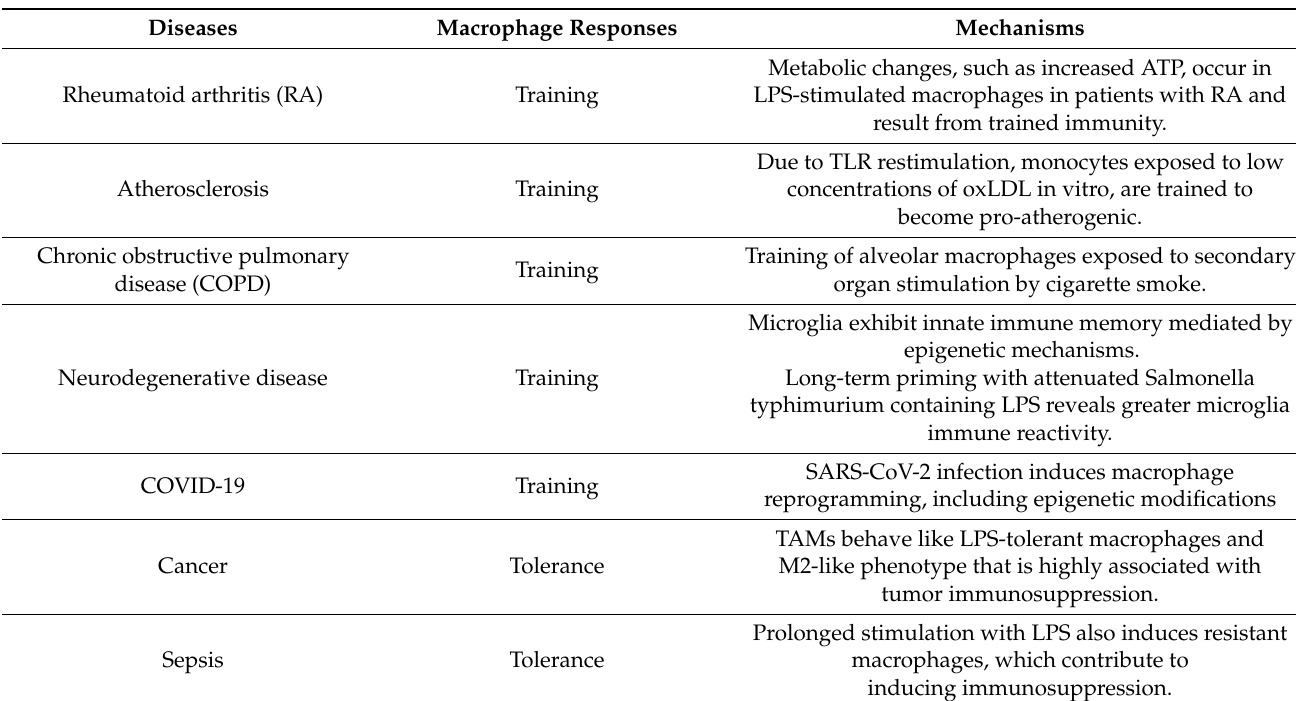
Table 2. Disease linked to abnormal macrophage